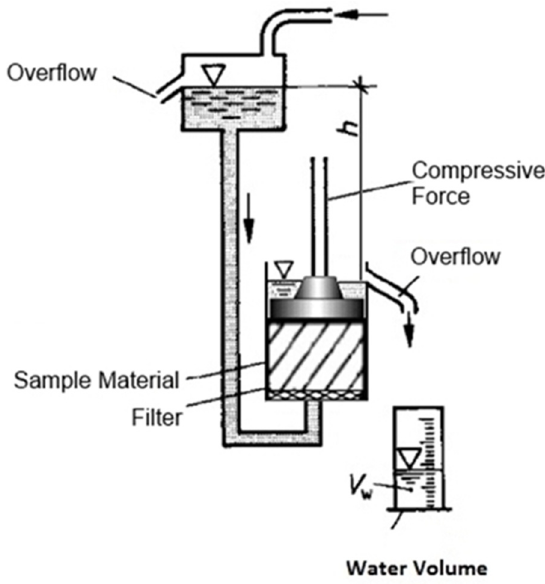
Figure 1. Schematic illustration of the oedometer testing appartus.